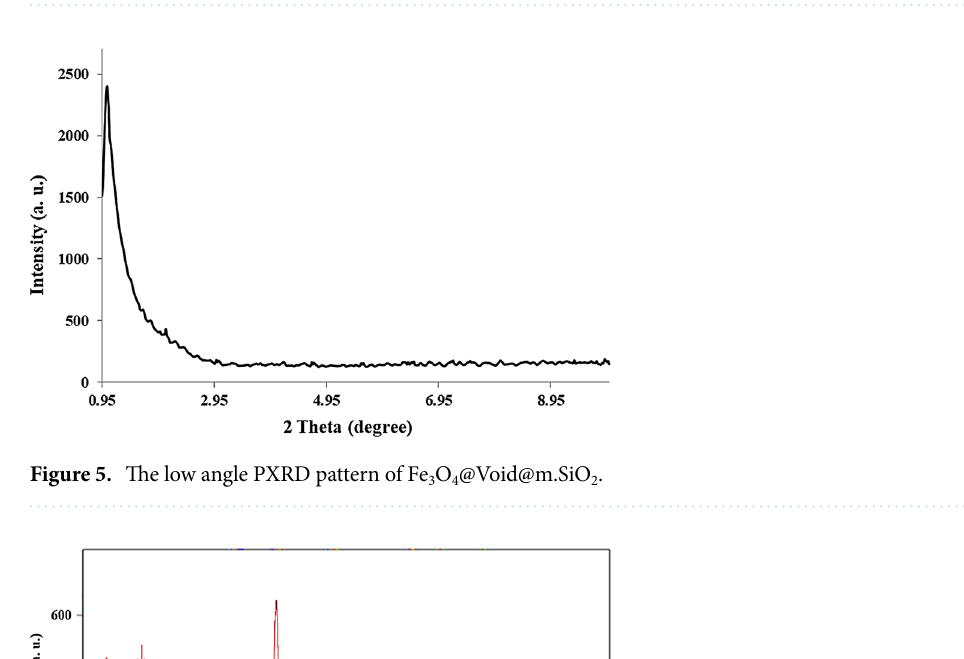
Figure 4. TEM image of Fe 3 O 4 @Void@m.SiO 2 .